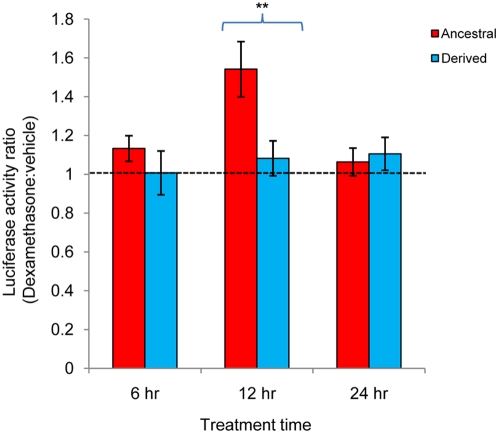
SNP rs9493857 affects glucocorticoid-mediated transcription.SK-BR-3 cells were transiently transfected with a pCMV-ß-galactosidase vector and either the SGK1 enhancer ANCESTRAL-luciferase or the DERIVED-luciferase reporter plasmid. Cells were split into duplicate plates and treated with either vehicle (EtOH) or dexamethasone (10−6 M). Luciferase activity was measured as described previously [91]. The relative luciferase activity in each condition was normalized to ß-galactosidase activity to account for transfection efficiency. Fold change was calculated after normalization to the pGL3 empty vector and reported as an average±standard error of four independent experiments. **, Significant (p = 0.002) one-tailed t-test.